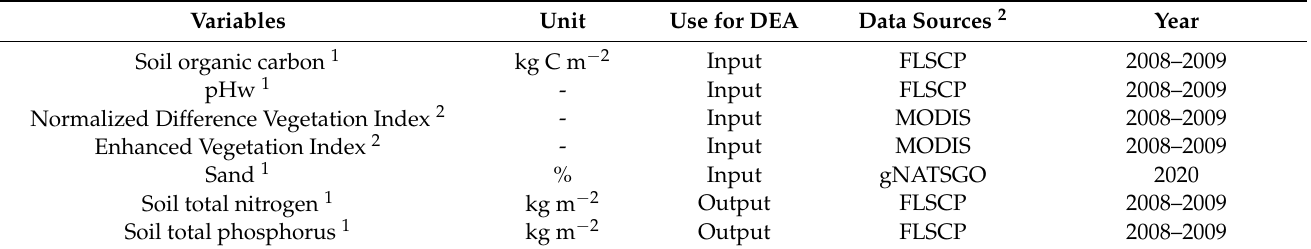
Table 1. Input and output variables used in the Data Envelopment